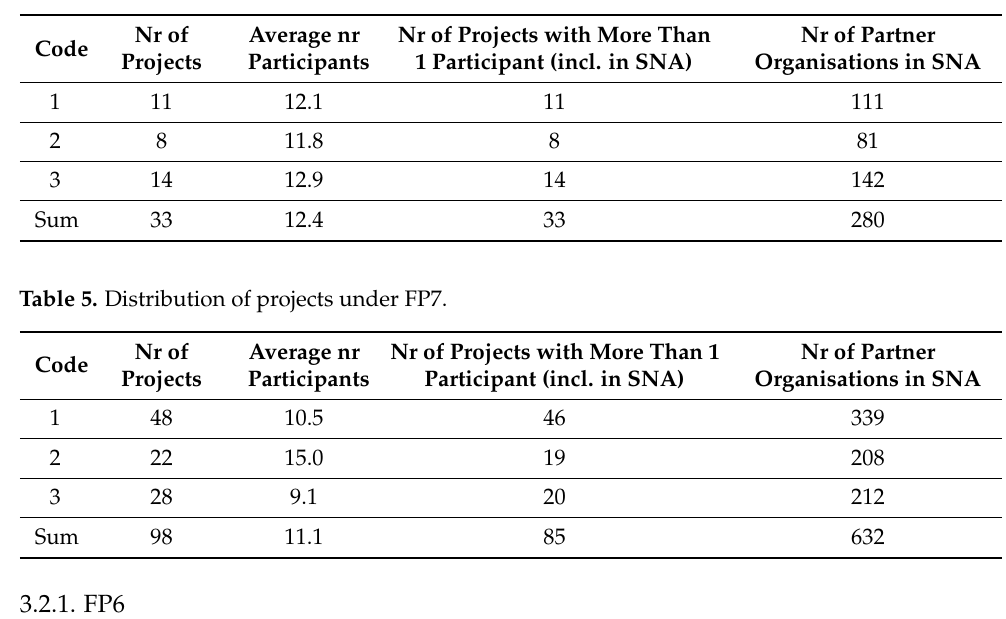
Table 4. Distribution of projects under FP6.